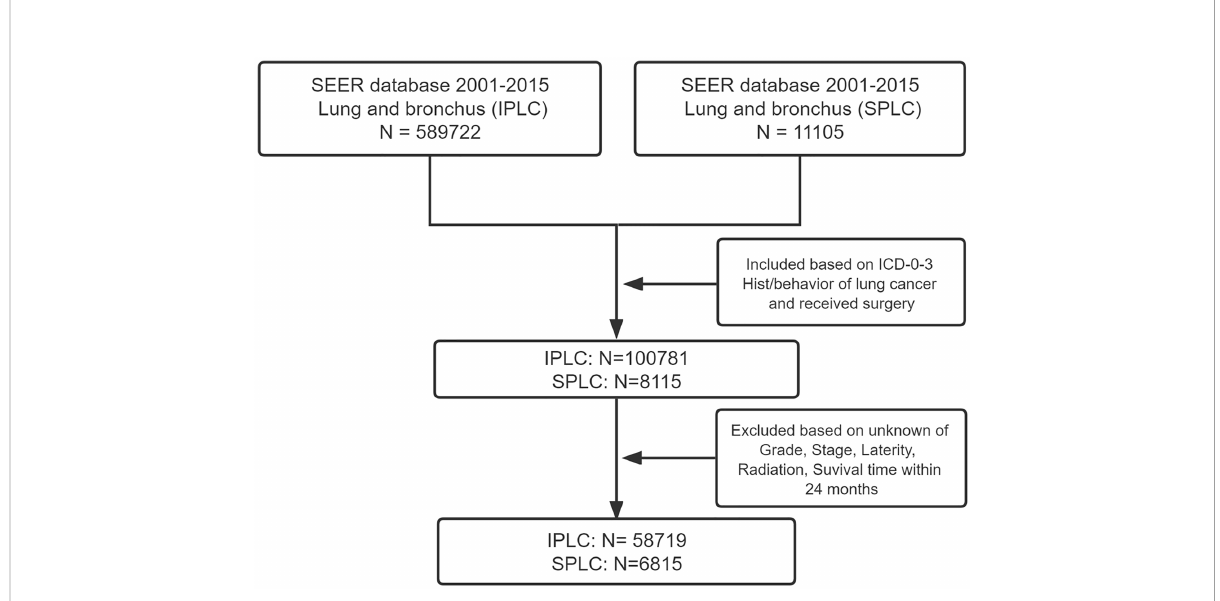
FIGURE 1 Selection strategy of